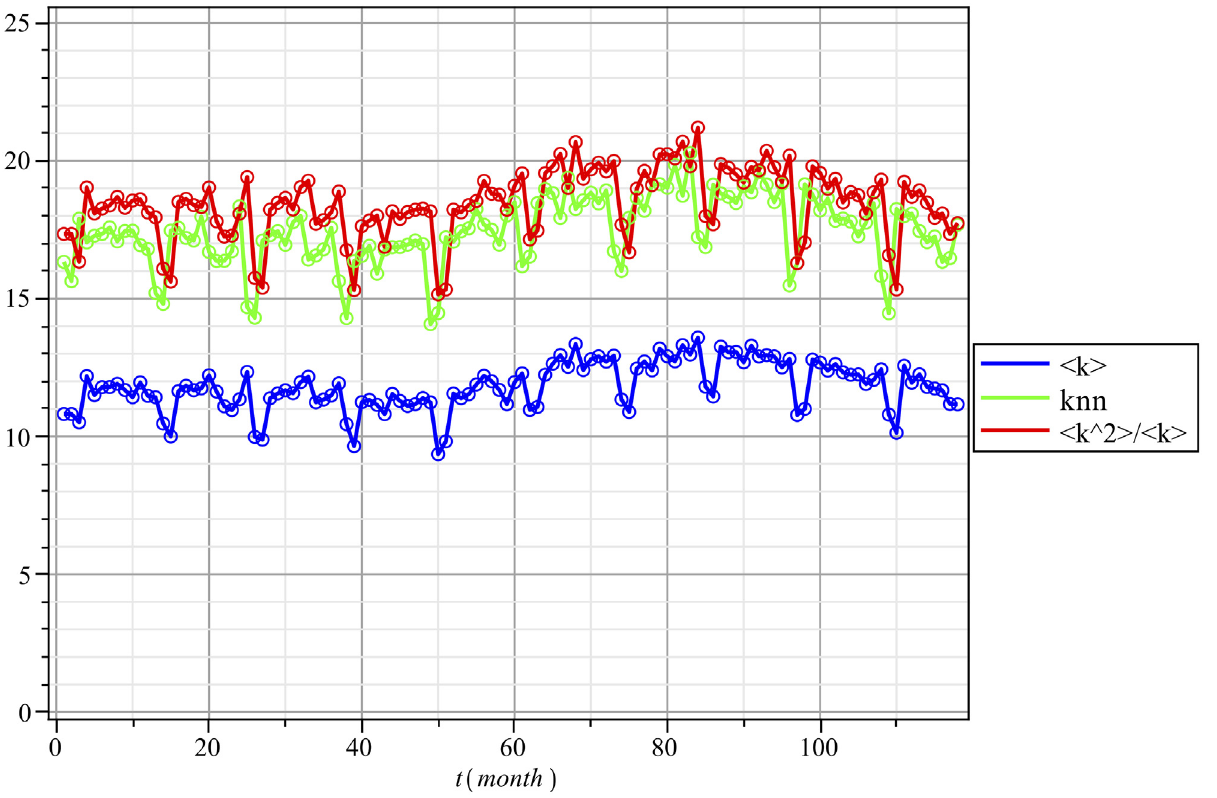
Fig 5. Average degree h k i , average nearest neighbor degree k nn , and variance-to-mean ratio h k 2 i